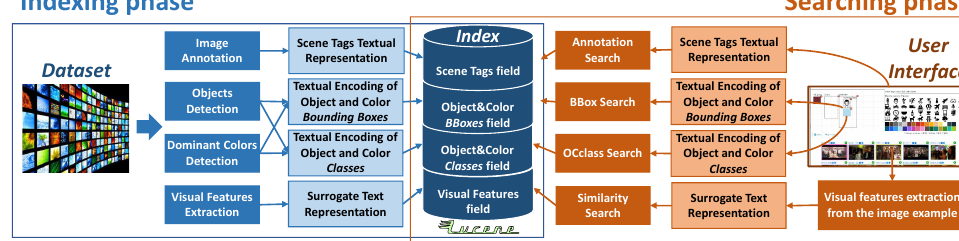
Figure 5. System Architecture: a general overview of the components of the two main phases of the system, the indexing and the